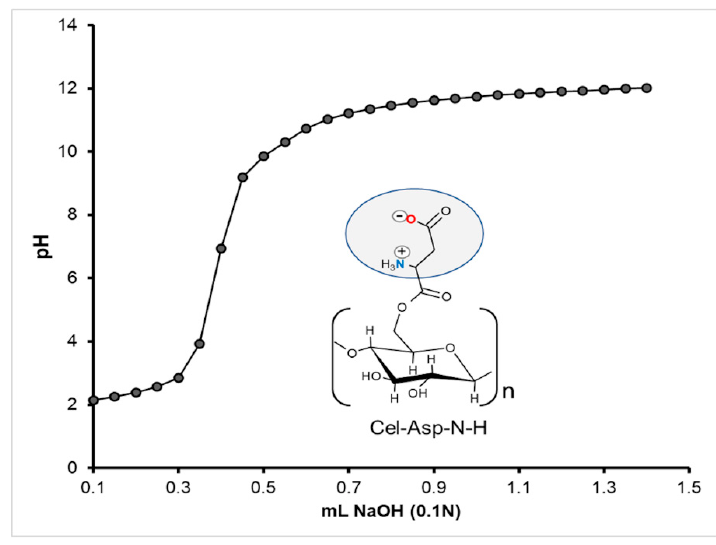
Figure 5. Titration curve of the Cel-Asp-N-deprotected.